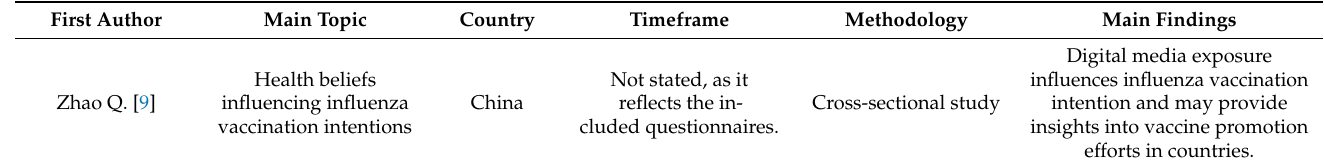
Table 1. Description of the manuscripts accepted for the Special Issue “The Willingness toward Vaccination: A Focus on Non-mandatory Vaccinations” in chronological order of